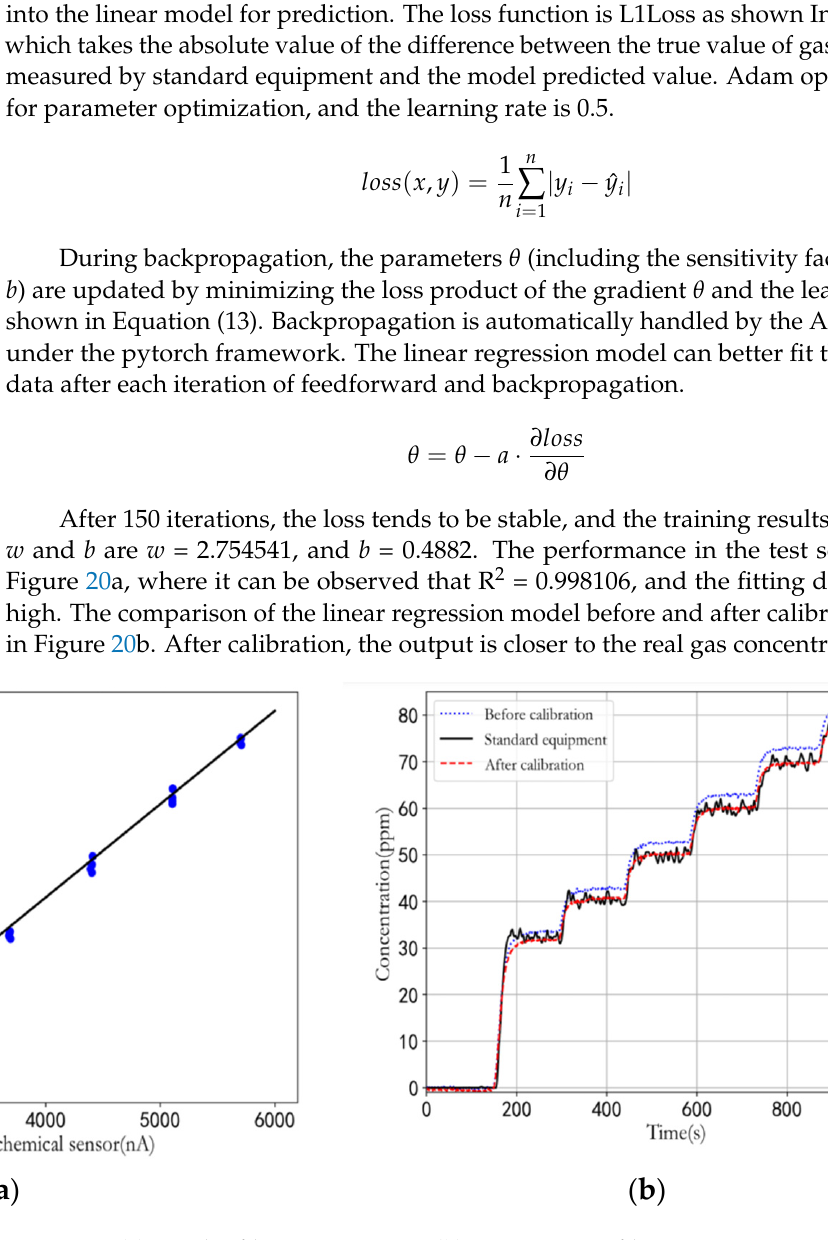
Figure 20. ( a ) Result of linear regression; ( b ) Comparison of linear regression model before and after calibration.